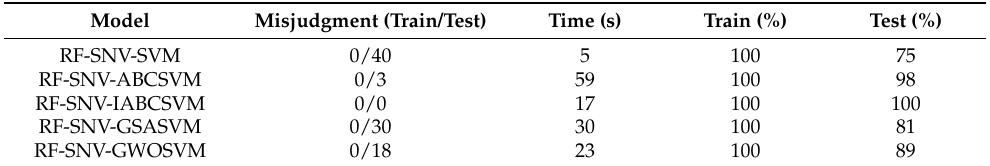
Table 11. After SNV preprocessing, the random forest algorithm is used for feature extraction, and the actual breeding resistance–susceptibility classification models established by four optimized support vector machine